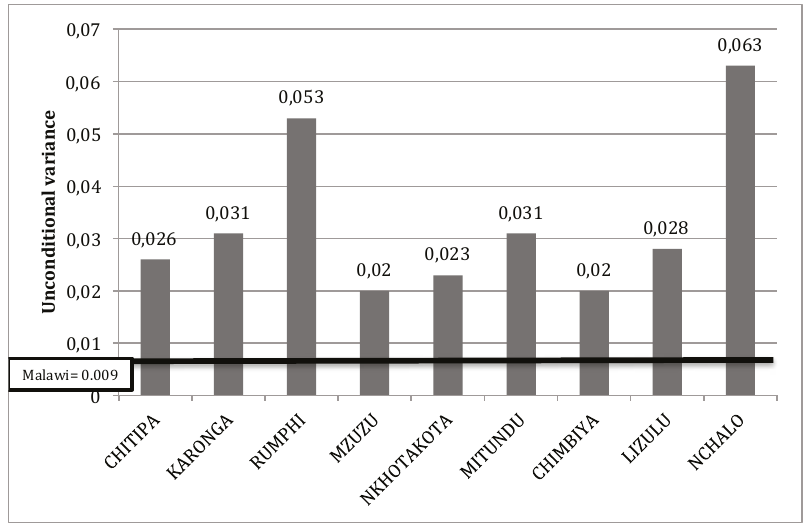
Figure 4. Unconditional variance of the unpredictable component of maize price for the Malawian local-economy markets and country-average value (January 1991-March